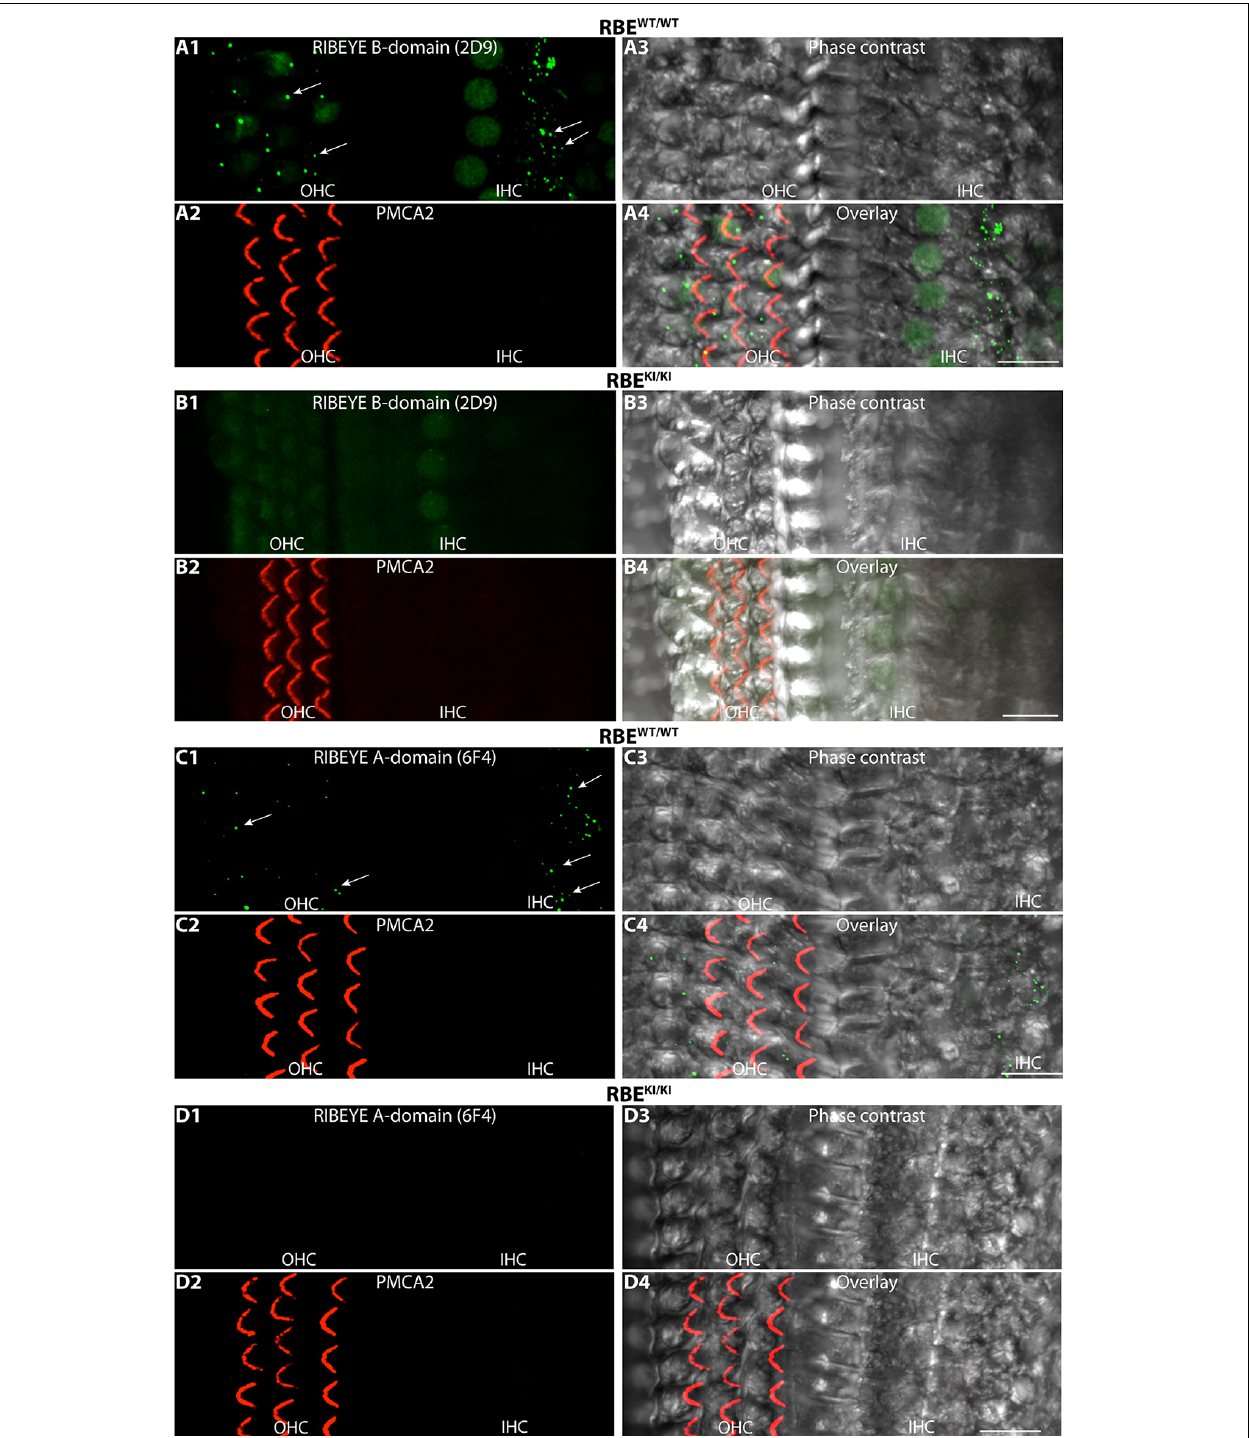
FIGURE 13 | RIBEYE B-domain immunosignals are absent in inner and outer hair cells in the inner ear of RBE KI/KI mice. (A1–A4,B1–B4,C1–C4,D1–D4) Whole mounts of mouse organs of Corti (isolated from RBE WT/WT and RBE KI/KI mice, as indicated) were double-immunolabeled with mouse monoclonal anti-RIBEYE B-domain antibody 2D9 (A,B) /mouse monoclonal anti-RIBEYE A-domain antibody 6F4 (C,D) and rabbit polyclonal antibody against PMCA2 to label stereocilia of outer hair cells (Watson and Temple, 2013; Bortolozzi and Mammano, 2018; Lin et al., 2021). The apical turns of the organs of Corti were used for the analyses. In the immunolabeled whole mounts, ribbons are clearly visible in the inner and outer hair cells (arrows) of RBE WT/WT wild-type mice but not in RBE KI/KI mice. All images are representative maximum projections obtained from the respective z -stacks. Abbreviations: IHC, inner hair cells; OHC, outer hair cells. Scale bar: 12 µ m.